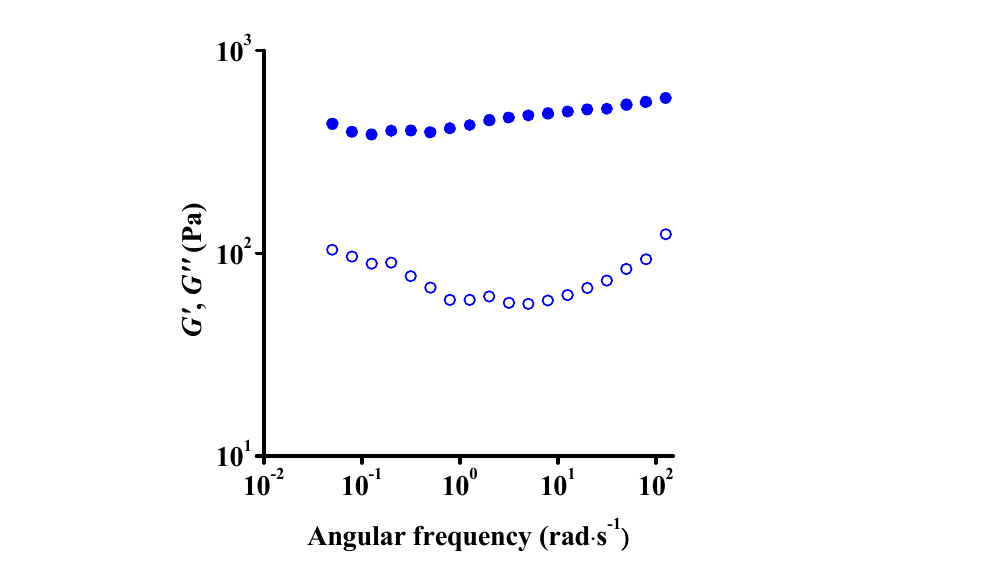
Figure 5. Dynamic frequency sweep of the fresh suspension at constant strain amplitude 0.1%. Data points above 100 rad · s − 1 are of an approximate nature due to the instrument limits. Solid and open symbols represent storage ( G ’) and loss ( G ”) moduli, respectively. Results of the parallel measurements and inertial limits of the measurements are shown in Figure S5.